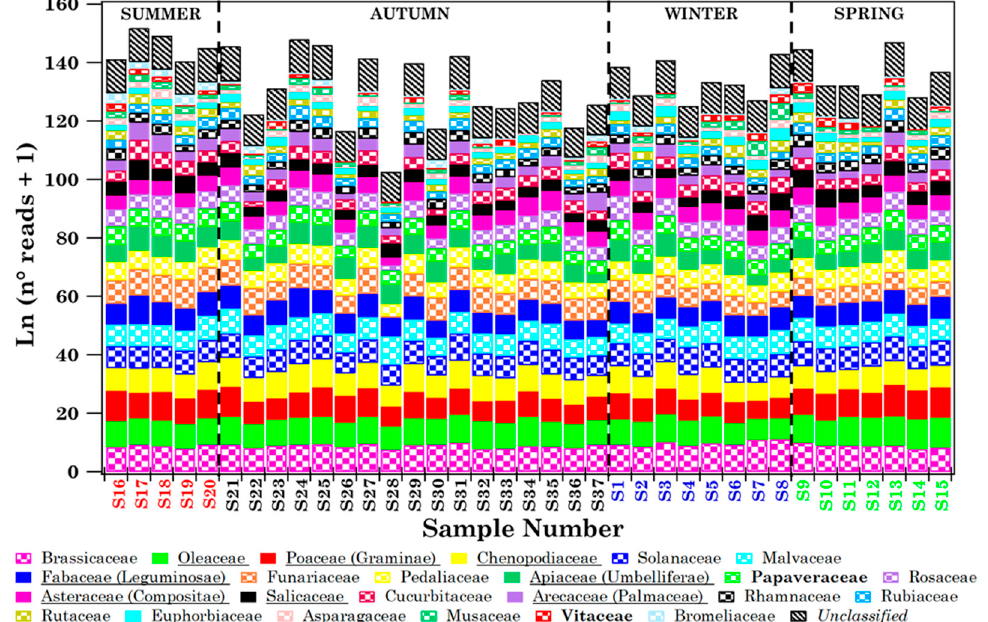
Figure 8. Natural logarithm of the number of reads (+1) of the Streptophyta families in each of the 37 samples collected in Lecce. The detected 24 Streptophyta families are listed in the legend, where the underlined ones represent the nine pollen families detected also in Brindisi. Papaveraceae and Vitaceae, which are in bold, have only been detected in Lecce. The not-classified Streptophyta families, denoted as Unclassified , are also reported in the plot. Samples are listed according to the sampling date. Each sample colour indicates a different season (red: summer, black: autumn, blue: winter, and green: spring).